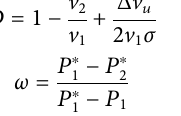
Frontiers in Energy Research |